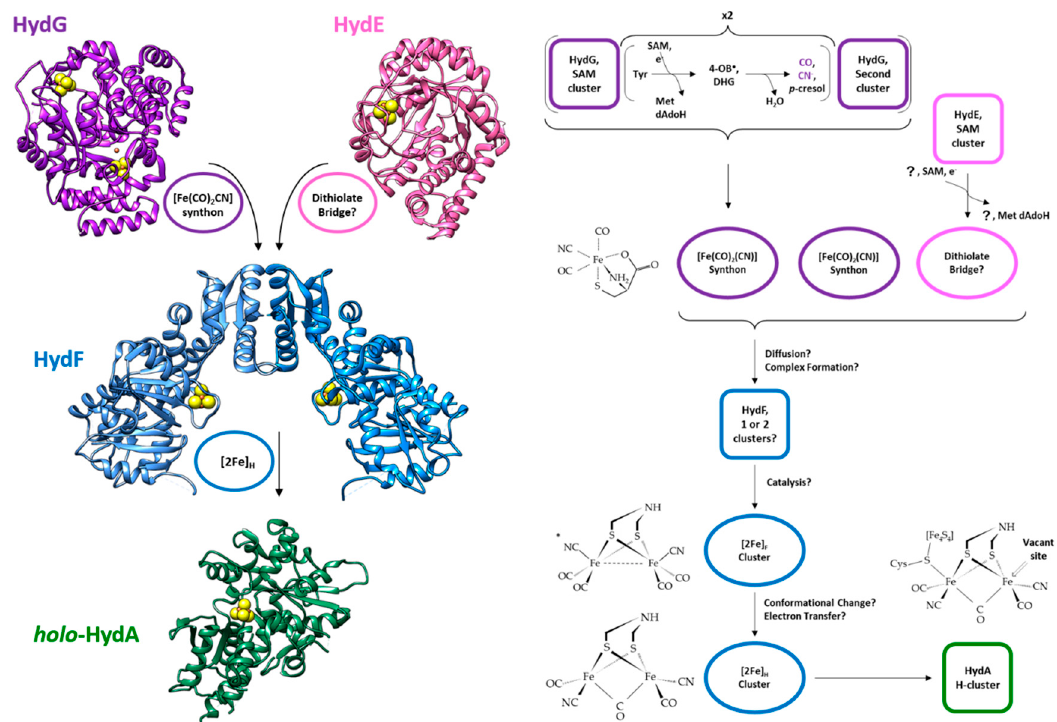
Figure 1. Scheme of the maturation process of the [2Fe] H sub-cluster of [FeFe] hydrogenase. On the left side, we show the structures and active sites of the enzymes involved in the maturation: purple, HydG from T. italicus (pdb.id 4WCX) with the first active site, the SAM cluster on top, and the second active site on the bottom; pink, HydE from T. maritima (pdb.id 3CIW); blue, HydF) from T. melaniensis (pdb.id 5KH0); green, HydA, from C. reinhardtii (pdb.id 3LX4), without the complete active site. On the right side, a more detailed scheme of the reactions involved in the process. The enzymes are indicated as squares (the color scheme is conserved); the products of the enzymes are shown as ovals of the same color of the enzymes producing them. Some relevant chemical structures are reported, from top to bottom: the synthon; the [2Fe] F cluster; the [2Fe] H cluster; and the active site of the holo-HydA with the full H-cluster. The question mark denotes unknown substrates/products; the asterisk denotes the attachment point of the [2Fe] F sub cluster to HydF. For the acronyms, please refer to the abbreviation